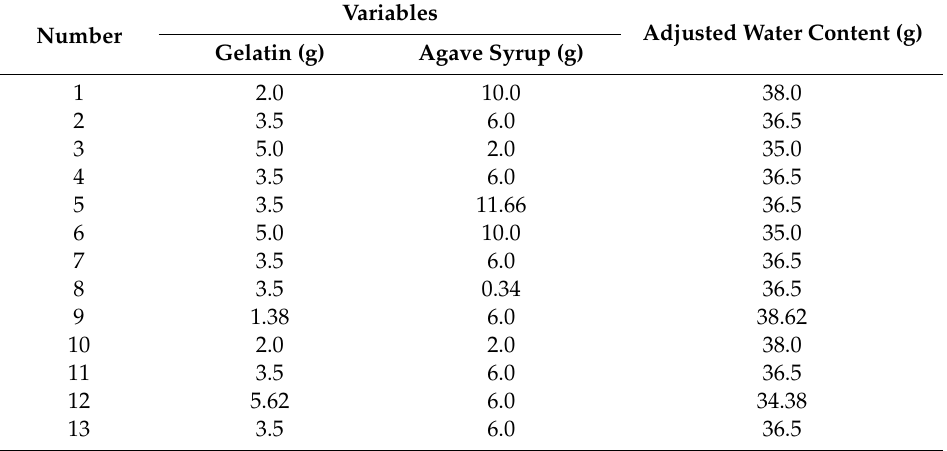
Table 6. Selected variables and experimental design matrix of gummy bear